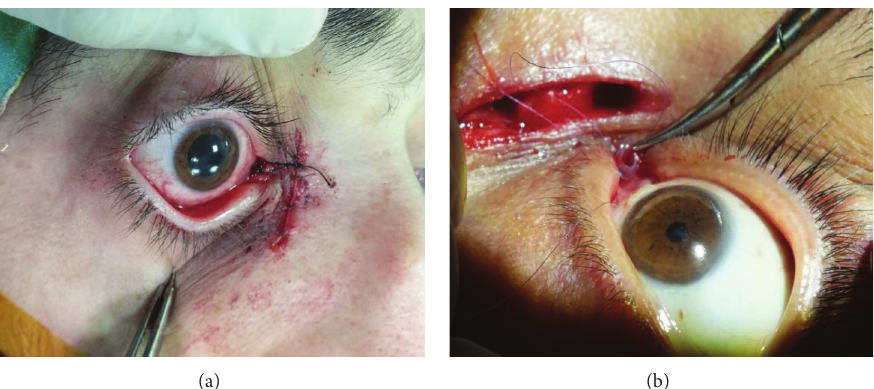
Figure 1: (a) At the final stage of conjunctivodacryocystorhinostomy surgery performed with Medpor coated tear drainage tube, the tube is suspended to the nasal root by a silk suture and then secured. (b) In surgeries in which silicon tear drainage tubes are used, two 7/0 vicryl sutures are passed through the tube valves, thereby securing the tube to conjunctiva and